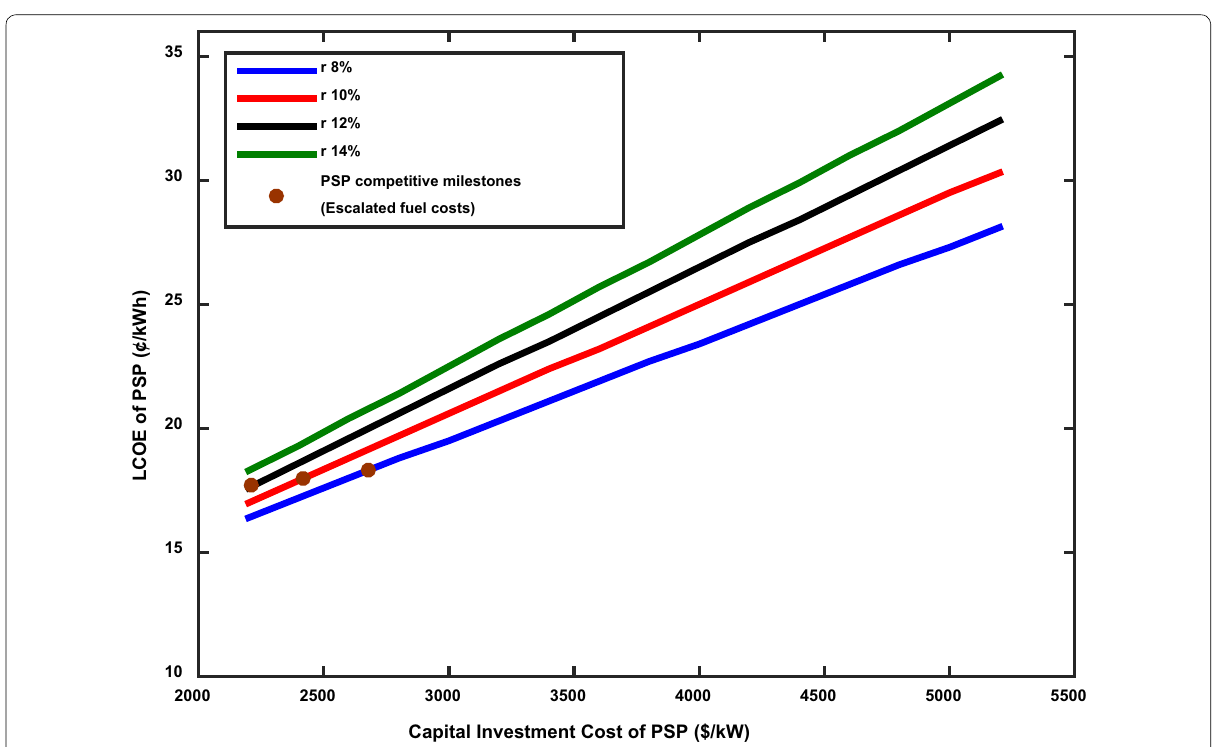
Fig. 7 LCOE of PSHPP versus variable capital cost at different discount rates (Scenario